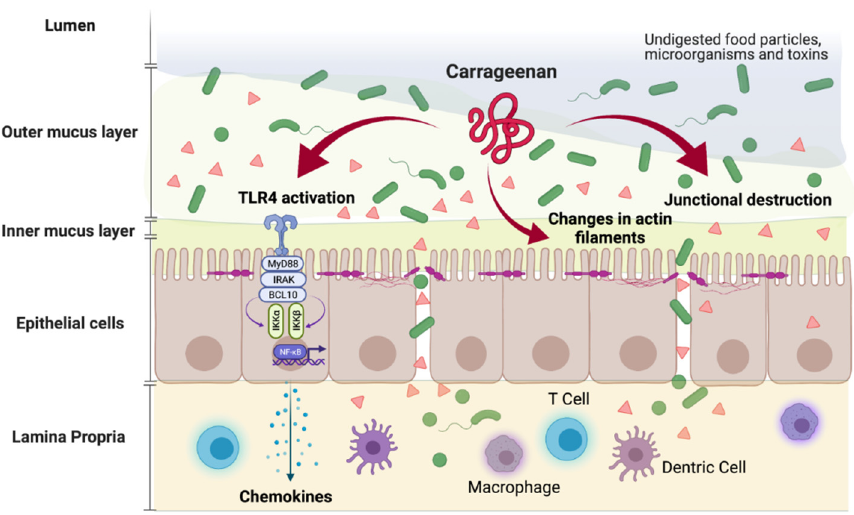
Figure 2. Carrageenan triggers the activation of the immune system and the development of inflammation (Made by © BioRender 2021). mation (Made by © BioRender